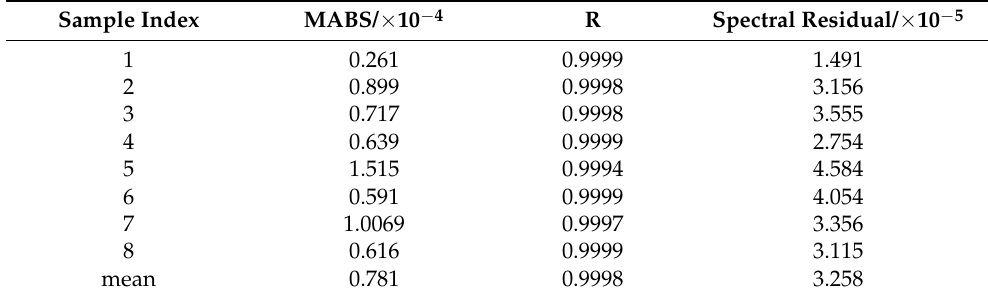
Table 3. Error analysis of molecular composition predicted from NIR spectroscopy for different